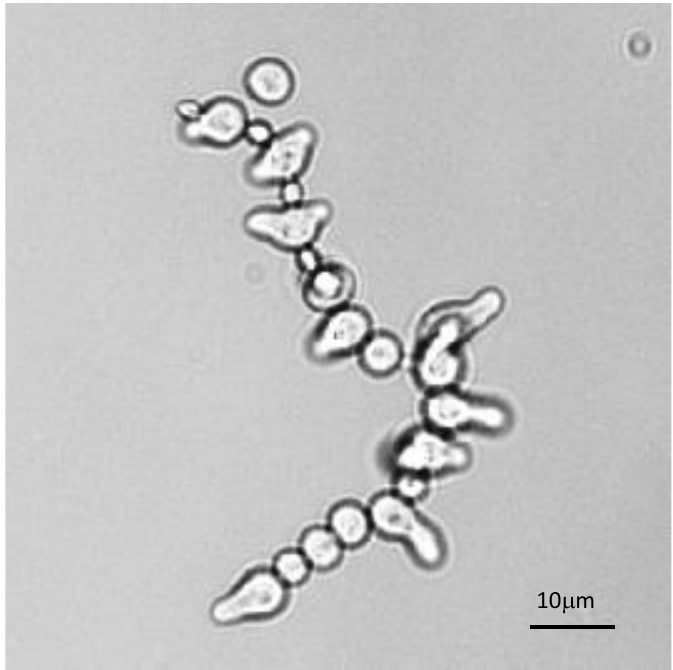
Figure 9. Asynchrony of conidial germination in a conidial chain of a glucanase mutant characterized by a defect in conidial separation. Note that the presence of resting, swollen or germinating conidia is totally independent of the conidium age.